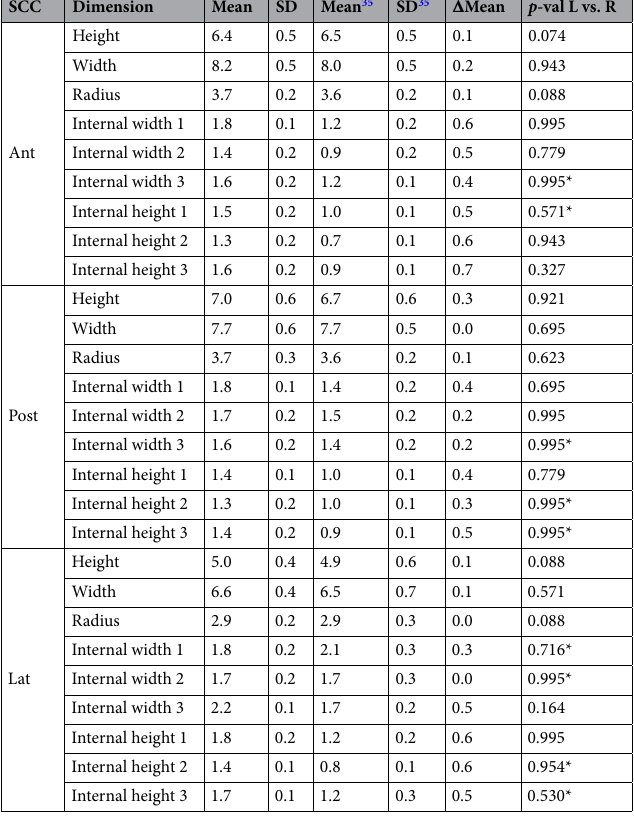
Table 3. Dimensions of the anterior (Ant), posterior (Post) and lateral (Lat) semicircular canals (SCC). SD indicates standard deviation. Unit: [mm]. *Indicates non-normal distribution (Kolmogorov–Smirnov test with Lilliefors correction, p < 0.05 ).